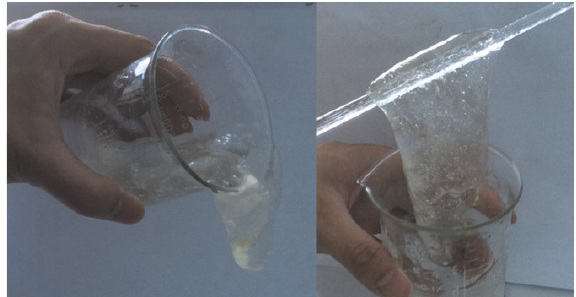
Figure 7: Cross-linking of guar with 20000 ppm NaNO 3 (Sample